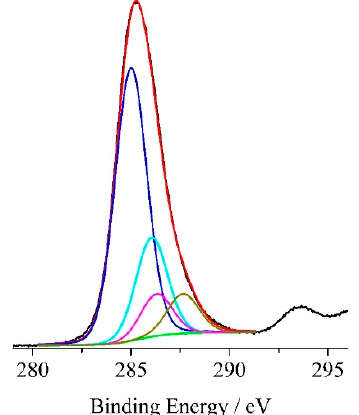
Figure 1. Al-K α excited XPS of the CNPs–naphthalic anhydride sample in the C 1s binding energy region. The blue, cyan, magenta and dark yellow lines refer to the 285.0, 286.0, 286.4 and 287.7 components; the green line refers to the background, and the red line superimposed to the experimental black profile refers to the sum of all Gaussian components.